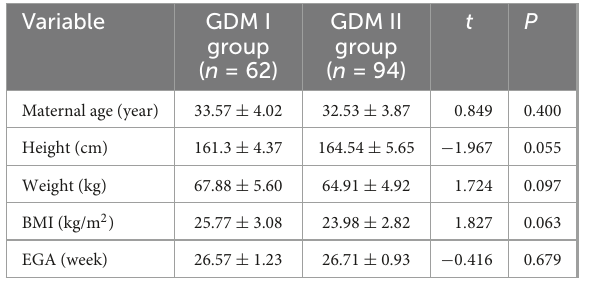
TABLE 4 Comparison of cardiac functional parameters between GDM I group and GDM II group.